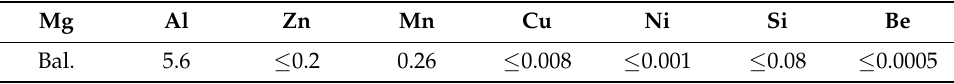
Table 1. Chemical composition (wt %) of rolled-plate AM60 magnesium